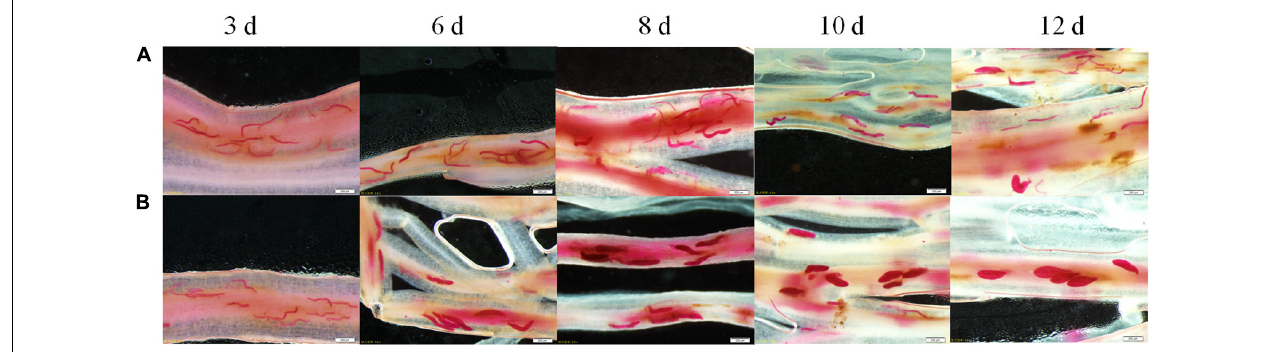
TABLE 1 | Number of clean reads and full-length reads, and full-length percentage. Treatment a Number of clean